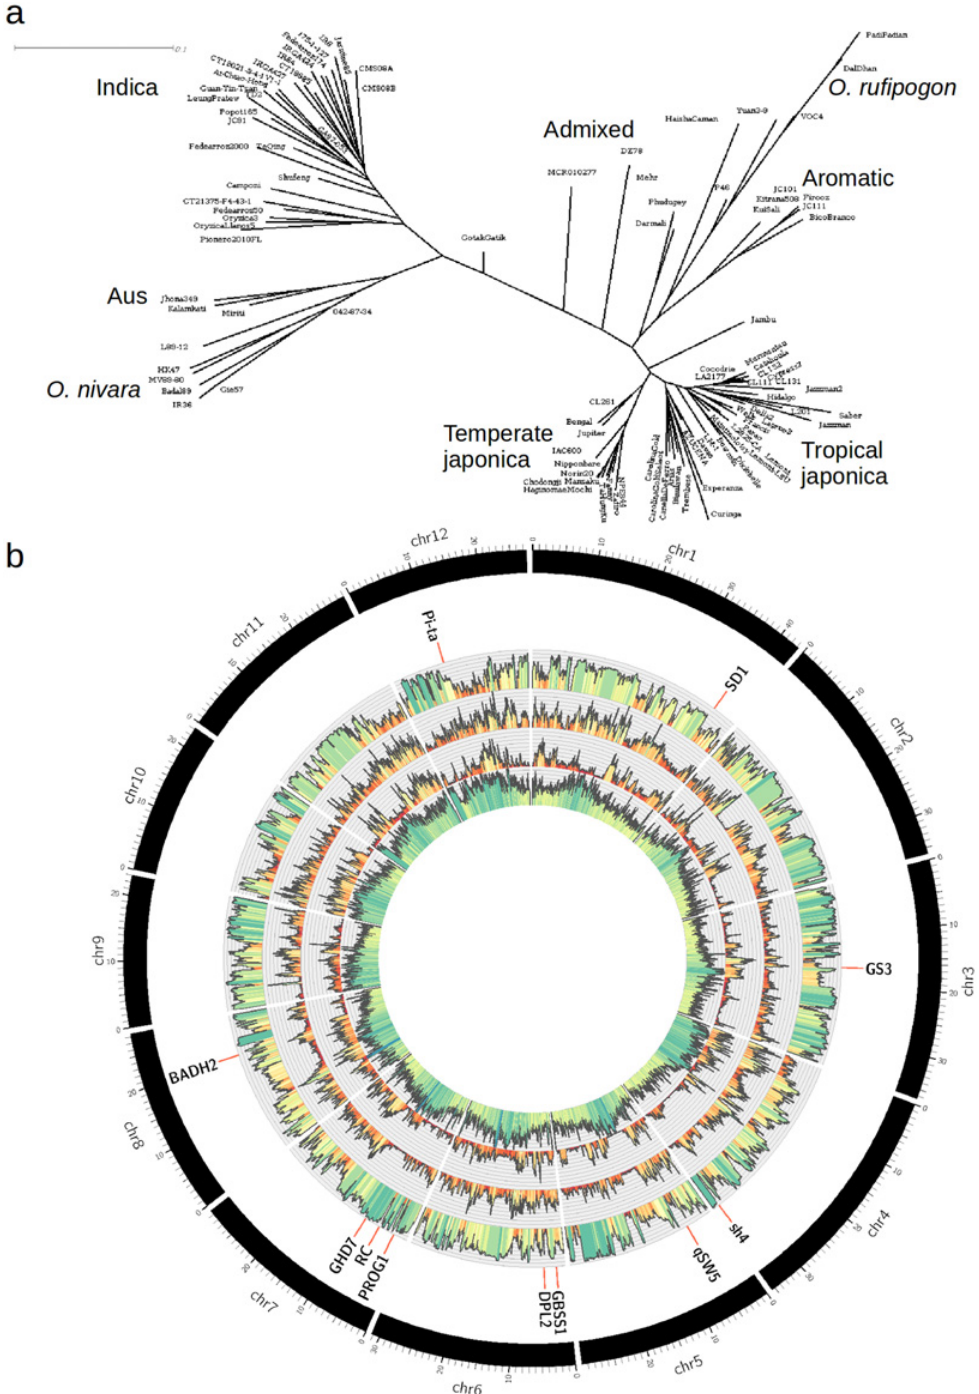
Fig 1. Genome-wide diversity patterns for sequenced cultivars of indica and japonica. a) Neighbor joining dendogram for the full dataset of accessions analyzed in this study. b) Moving from within to outside, the circles have the following information: 1). Density of repeat elements (0% to 100%). 2) Diversity within japonica (0 – 10). 3) Diversity within indica (0 – 10). 4) Pairwise Fst between indica and japonica (0 – 1). For each population, diversity is estimated in 100kbp windows as the average number of pairwise differences per kilobasepair (See methods for details). Green colors indicate values close to the maximum on each category (or larger for the case of diversity values). Red colors indicate values close to zero. Yellow colors indicate intermediate values. Genomic locations of genes related to selective sweeps are shown in red lines.